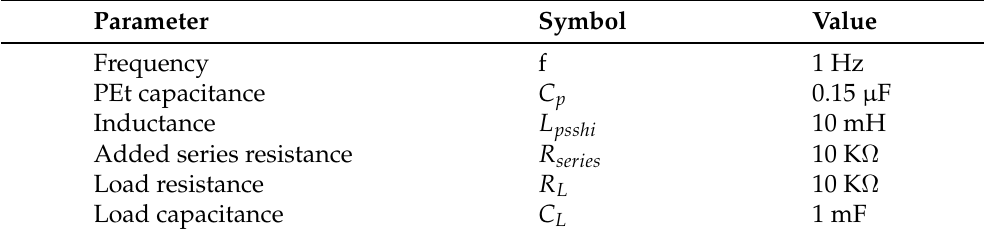
Table 3. Simulation parameters